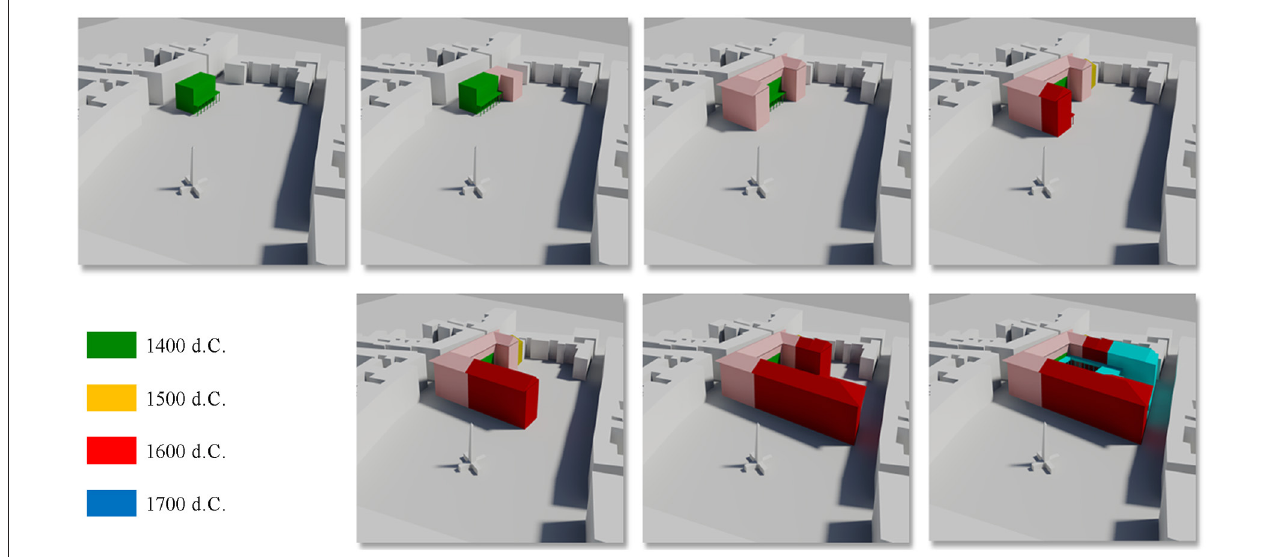
FIGURE 9 | Hypothesis of the morphological evolution of Palazzo